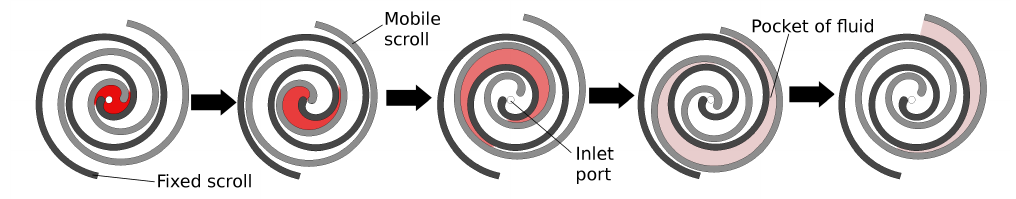
Figure 7. Working principle of a scroll